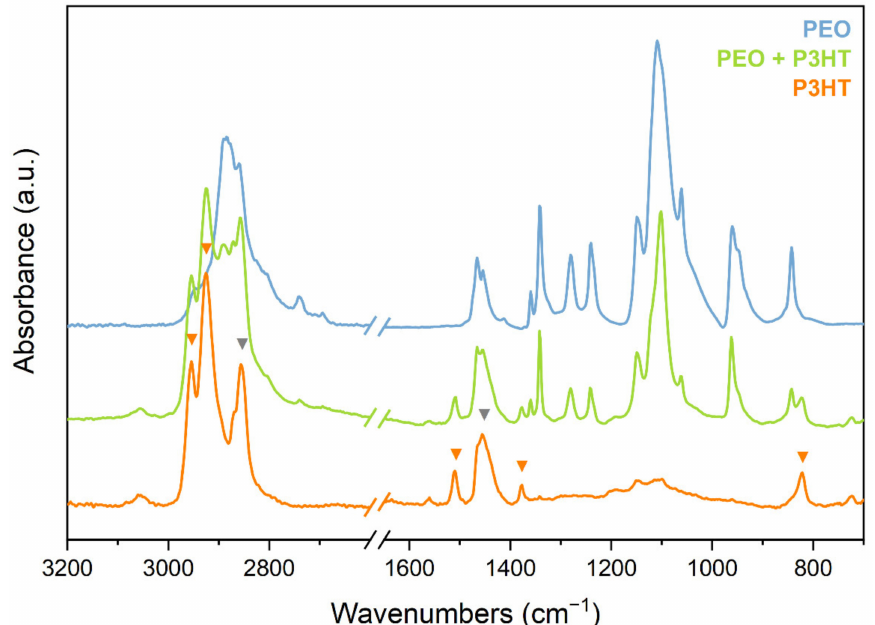
Figure 3. Infrared spectra of nanofibres, namely: pure PEO, blue line ; P3HT:PEO, green line ; P3HT (washed P3HT:PEO fibres), orange line . Spectra of P3HT and P3HT:PEO (orange and green line) have been normalised to CH stretching bands (2900 and 2955 cm − 1 ) of P3HT, the PEO spectrum (blue line) has been normalised to the P3HT:PEO spectrum (green line), considering the 1342 cm − 1 sharp peak of PEO. Orange triangles highlight features of P3HT that do not overlap with PEO peaks, and grey triangles indicate P3HT features showing a large overlap with PEO absorptions.